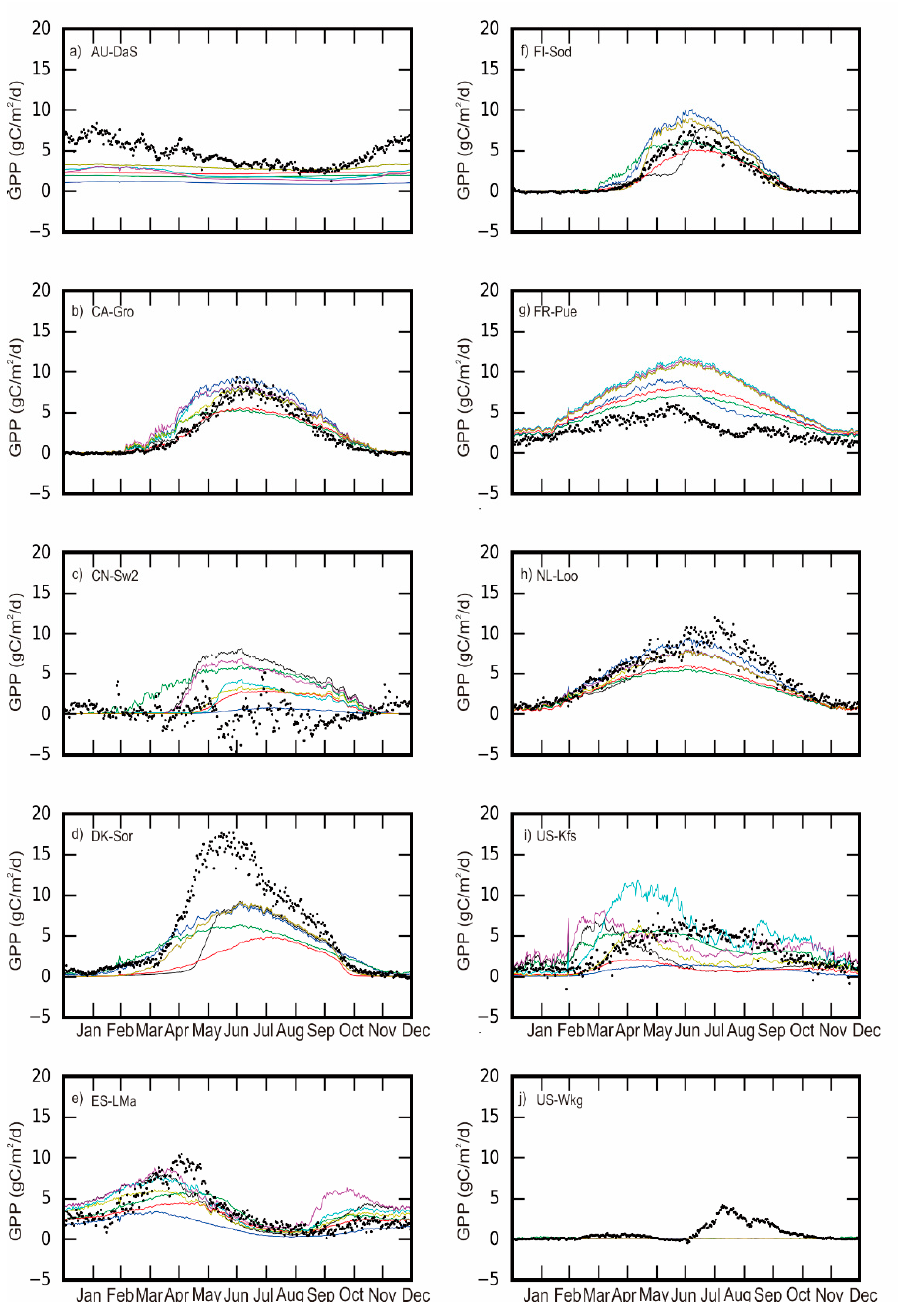
Figure A2. Multi-year mean of simulated daily gross primary productivity (GPP) and observed data (dot) from FLUXNET. ( a – j ) corresponds to 10 sites listed in Table A3. The black line denotes simulation with prior parameter values, the blue line denotes multi-site assimilation result with soil moisture and FAPAR, the green line denotes multi-site assimilation result with soil moisture, the red line denotes multi-site assimilation result with FAPAR, the cyan line denotes single-site assimilation result with soil moisture and FAPAR from each site grid, the magenta line denotes single-site assimilation result with soil moisture from each site grid, and the dark yellow line denotes single-site assimilation results with FAPAR from each site grid.